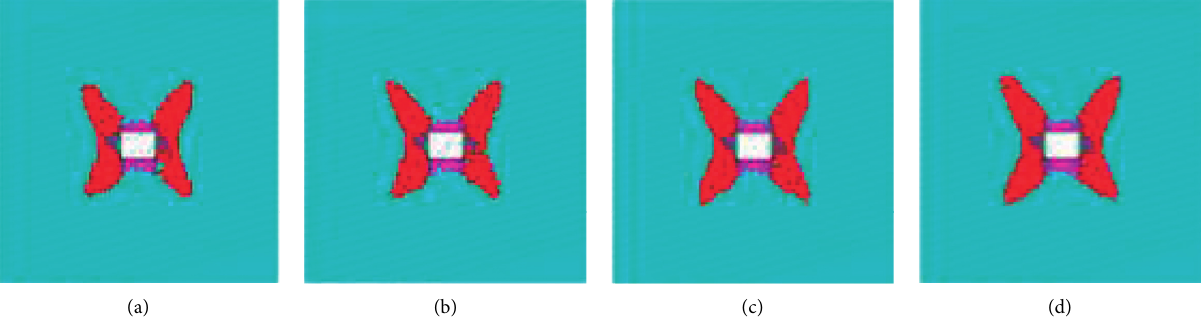
Figure 13: Morphology of plastic zone under different cohesion of rock strata. (a) 43 ° . (b) 44 ° . (c) 46 ° . (d) 47 °